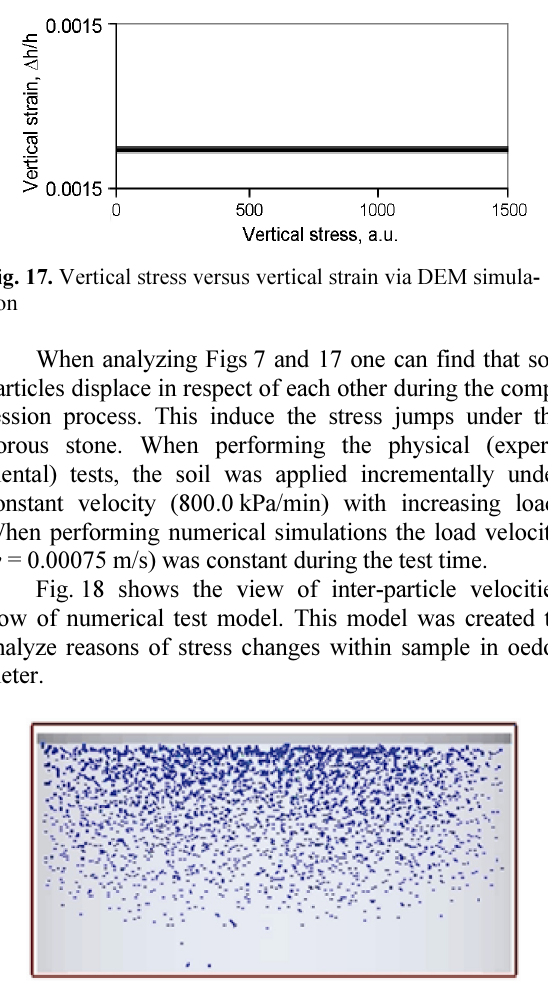
Fig. 16. Characteristic sand compression curve via DEM simu- lation